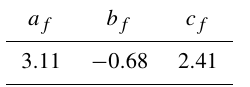
Table 1. Thrust coefficients and turbulent intensities for the consid- ered validation cases.